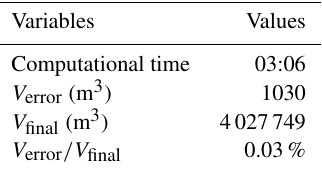
Table 6. Evaluation of software performance of Itzï in the test case of Hull. V error is the total volume created due to numerical instabil- ity during the simulation. V final is the total volume in the domain at the end of the